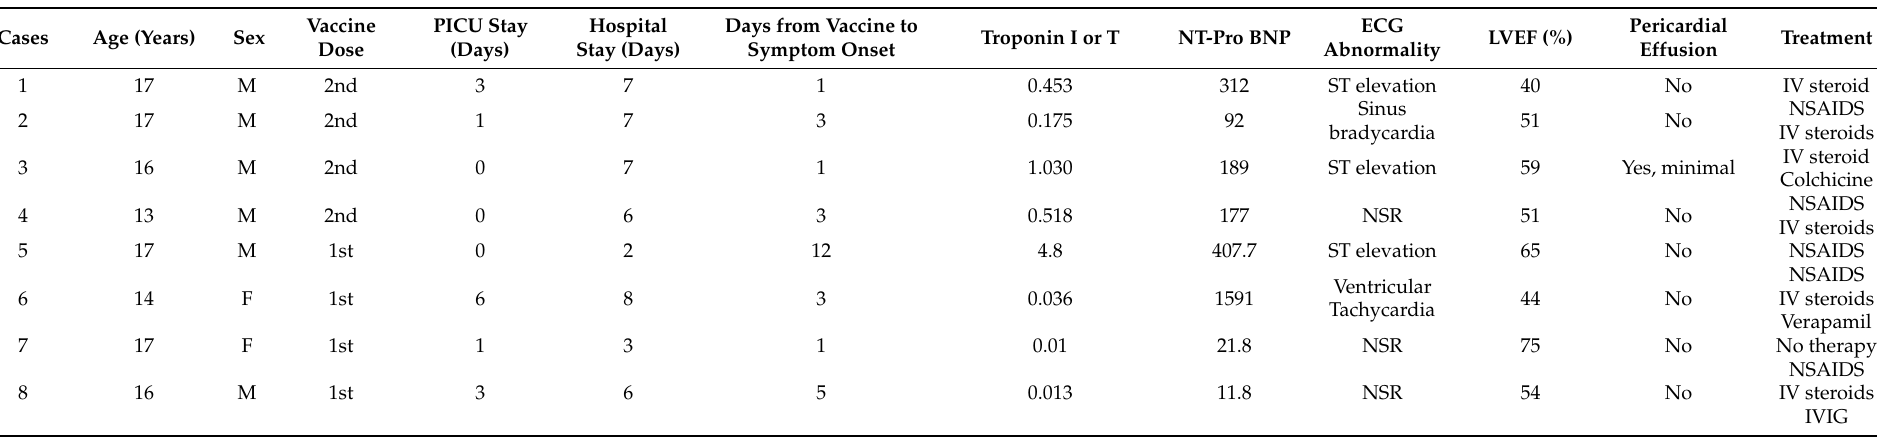
Table 4. Patient characteristics of adolescents who had suspected myocarditis related to COVID-19 vaccination and/or who required ICU